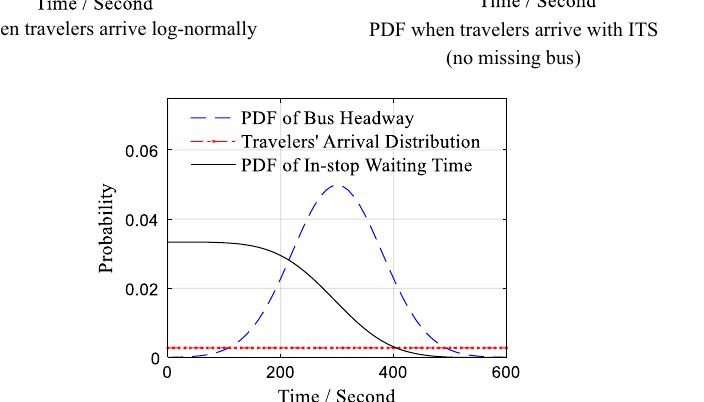
PDF when travelers arrive uniformly